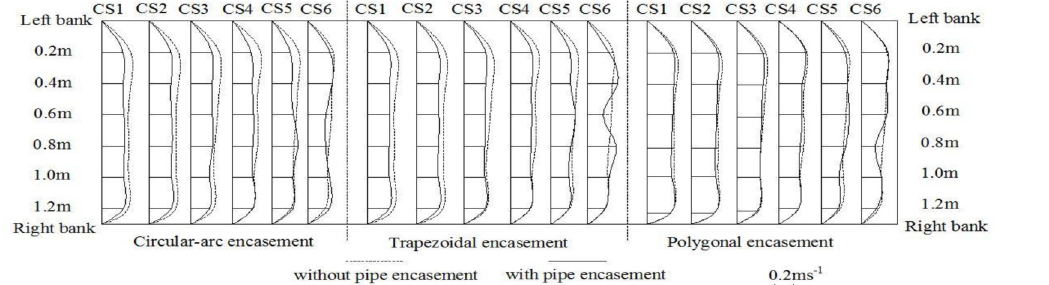
Fig 11. Distributions of flow speeds at CS1-CS6 for a 3-year flood event.